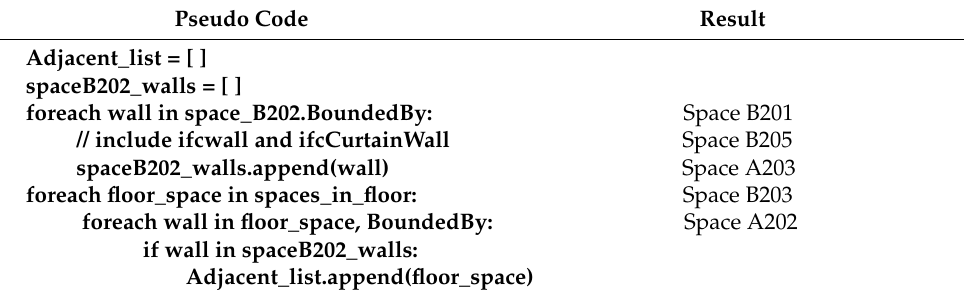
Table 1. IFC semantic-based query to extract space adjacency with the concept of the shared wall. Pseudo Code Result